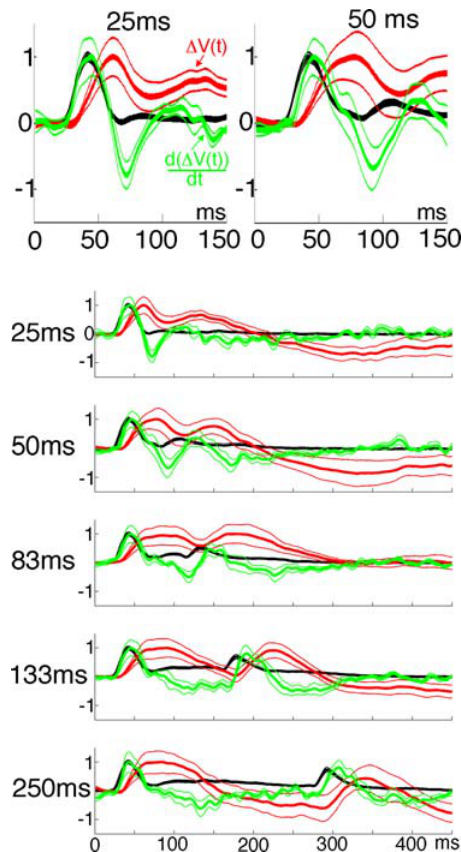
Figure 6. Mean relative firing rate, population membrane potential and d( D V(t))/dt. The mean relative instantaneous firing rate (black, calculated as D V(t)rel ), the mean D V(t)rel (red) and the mean time derivative of D V(t)rel d( D V(t)rel)/dt (green) calculated across all animals for each stimulus duration. The d( D V(t)rel) /dt is the relative change in the inward current in layers I–III (methods). The two top figures show the initial time-course of the relative firing rates, the D V(t)rel and the d( D V(t)rel)/dt at higher